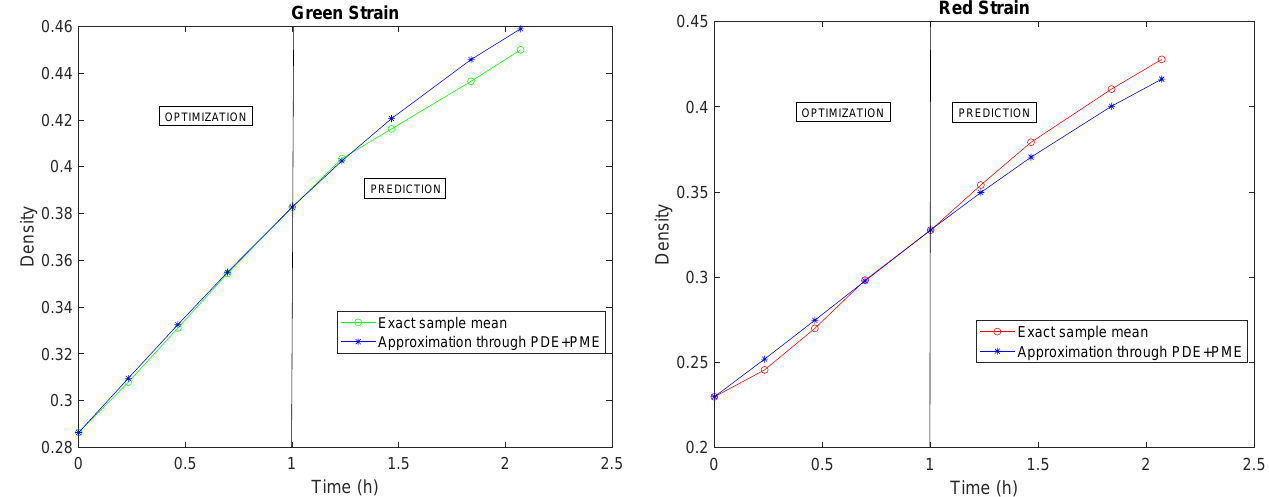
( a ) Mean path of the solution stochastic process for the green strain. ( b ) Mean path of the solution stochastic process for the red strain. Figure 8. Optimization, as computed in Section 5, and prediction of the mean paths of the solution stochastic process. The available data span over 2 h of